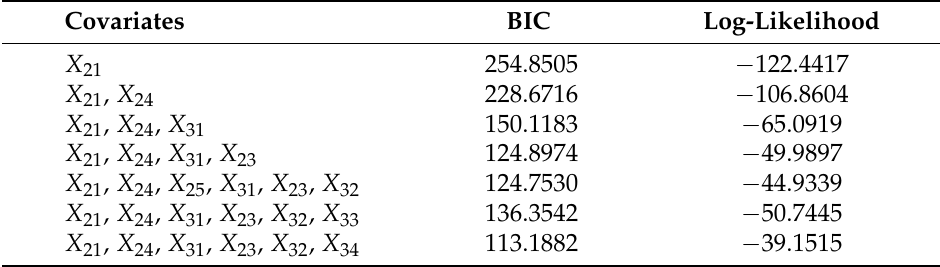
Figure 5. Profiled log-likelihood function with fixed ν from ν = 1, . . . ,20 ( a ), PP plot with KS acceptance bands at 5% ( b ), and index plot for transformed MD ( c ), using the BS- t model and Chilean PM data. Table 4. Results of the stepwise algorithm for the bivariate BS- t regression model and its correspond- ing BIC and log-likelihood values with Chilean PM